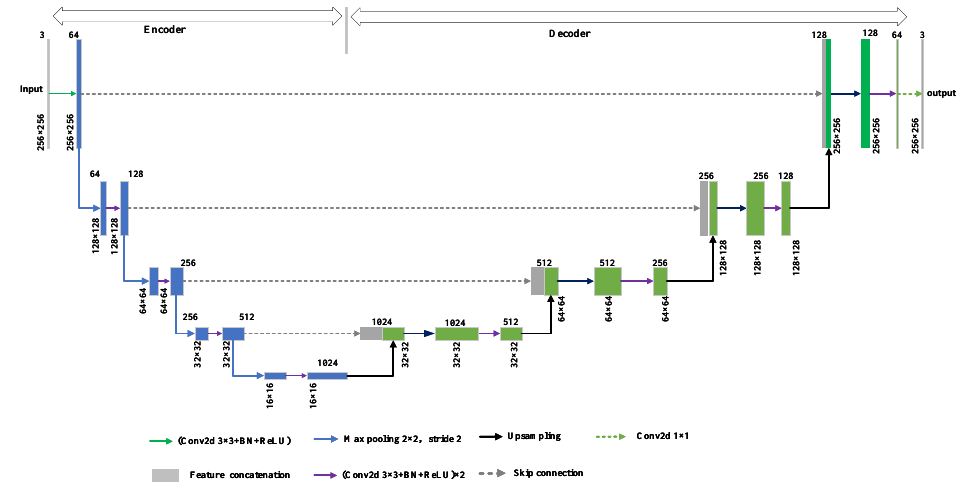
Figure 1. Structure of the classical U-net